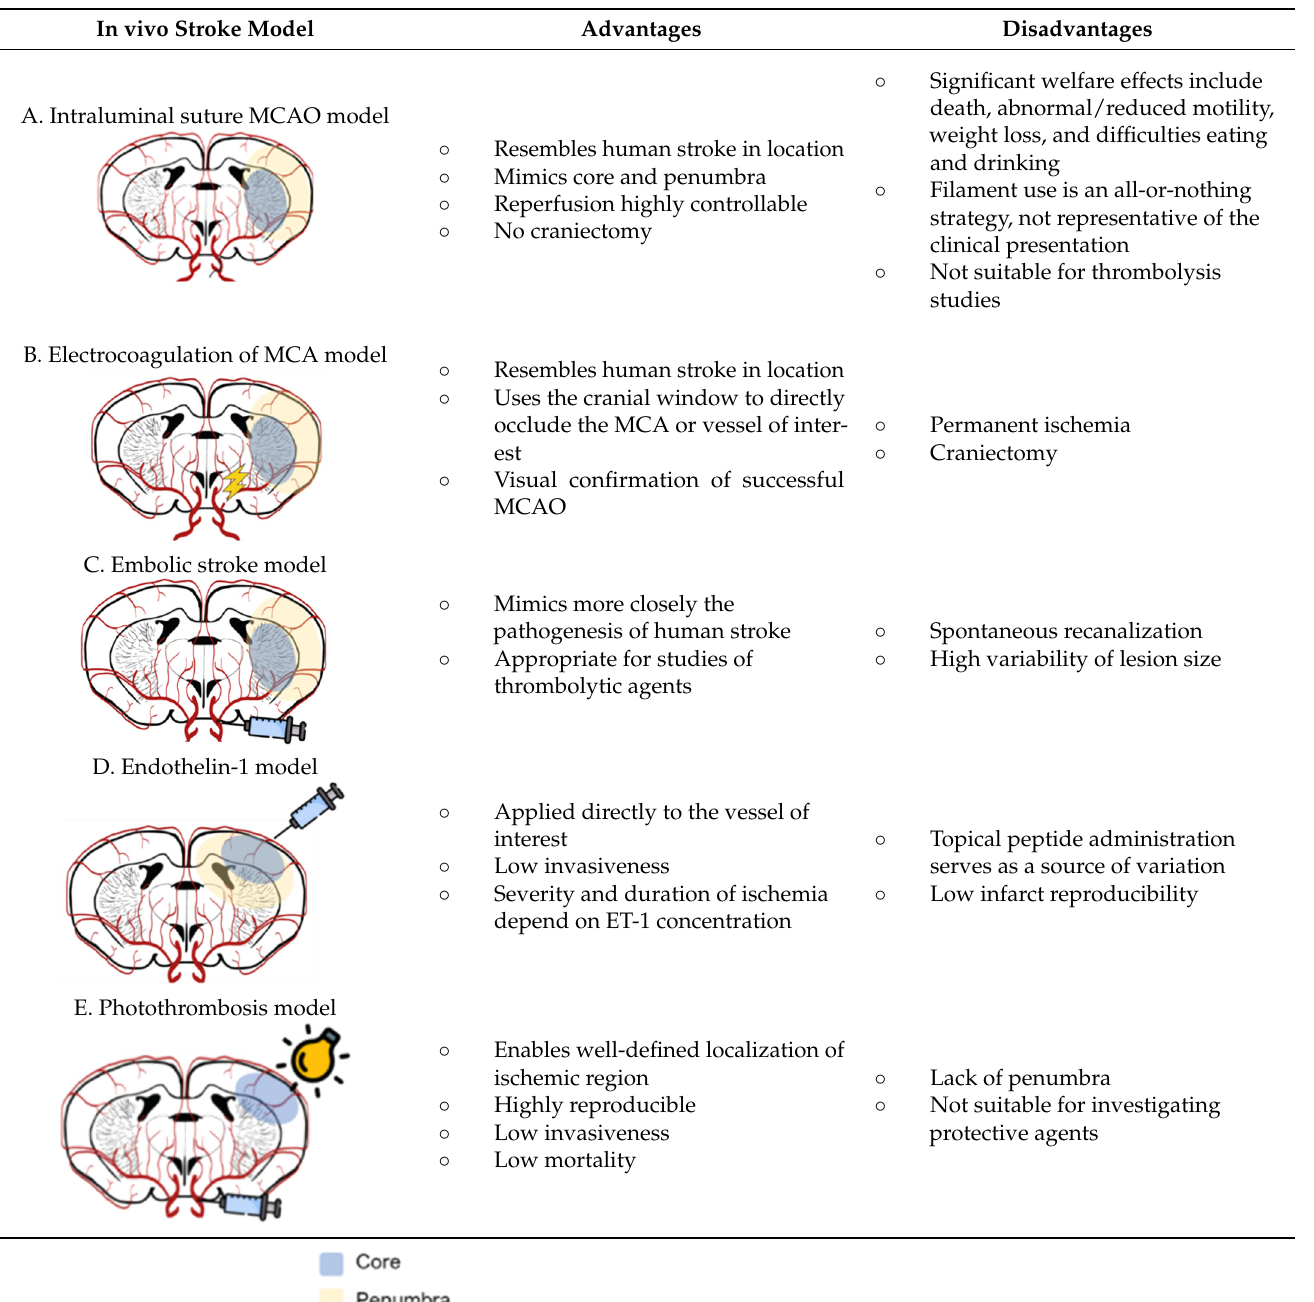
Table 3. Stroke models in vivo: illustrations of stroke models with a schematic representation of the affected areas (core and penumbra), and advantages and disadvantages of each model.